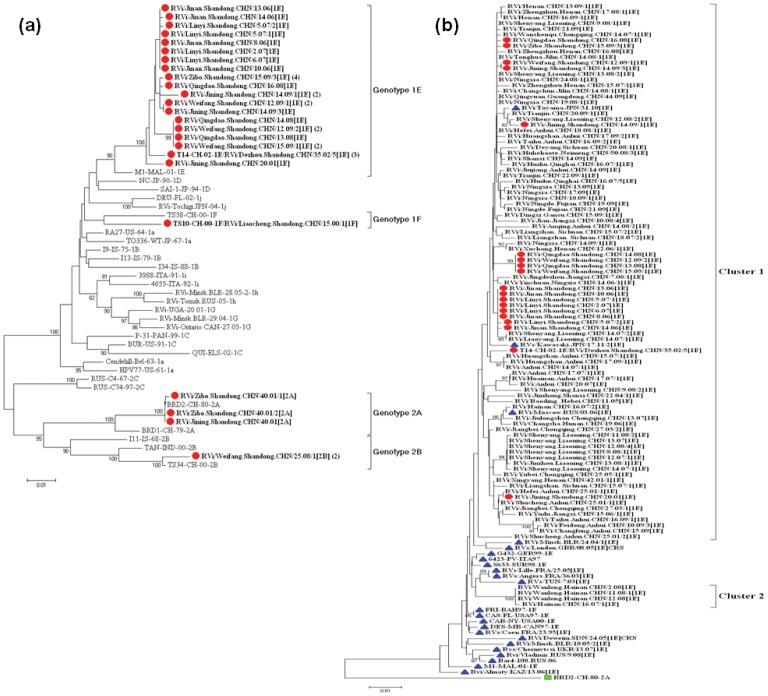
Phylogenetic analyses of sequences of Shandong rubella viruses based on the WHO standard sequence window.(a) Phylogenetic analysis of sequences of 24 representative rubella viruses from 2000–2009 compared with the WHO reference sequences. Numbers in parentheses are numbers of identical sequences found in the same outbreak. Shandong rubella viruses are indicated by a solid circle. (b) Phylogenetic analysis of representative Shandong rubella virus strains of genotype 1E compared with rubella viruses from the other provinces of China. Seventy-seven genotype 1E rubella virus strains from other provinces isolated during 2001–2009 were obtained from Genbank. Shandong rubella viruses are indicated by red solid circles, the genotype 1E rubella virus strains from other countries are indicated by blue solid triangle. The Chinese vaccine strain BRD II with a green solid square was used as an out-group.